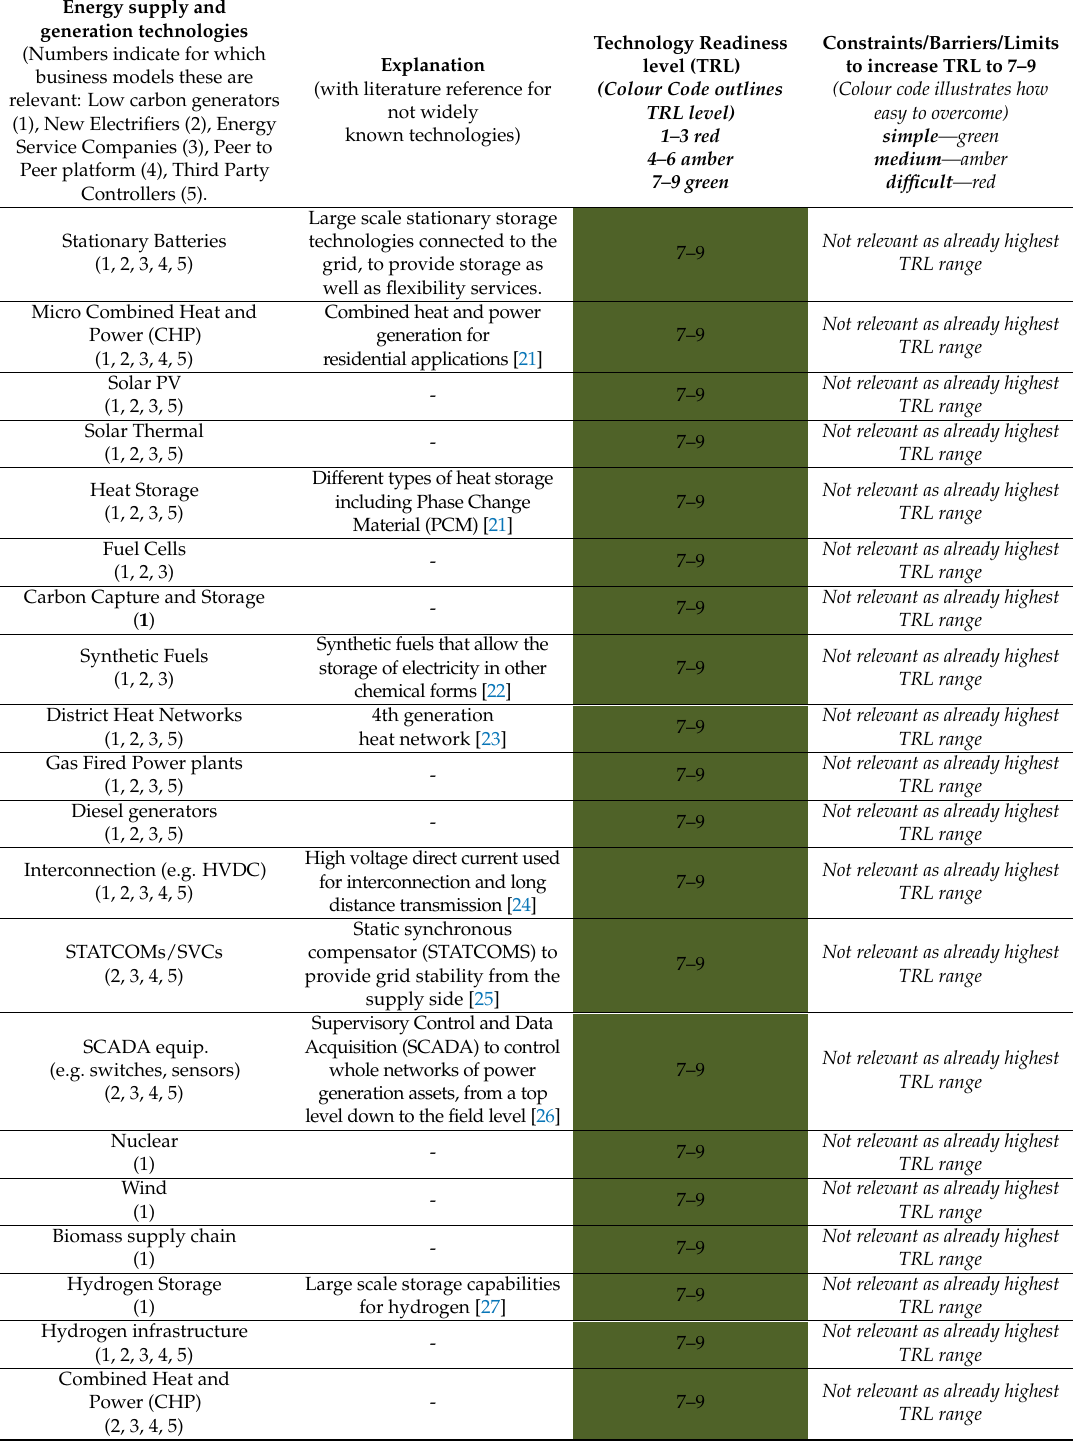
Table 3. TRLs of supply-side